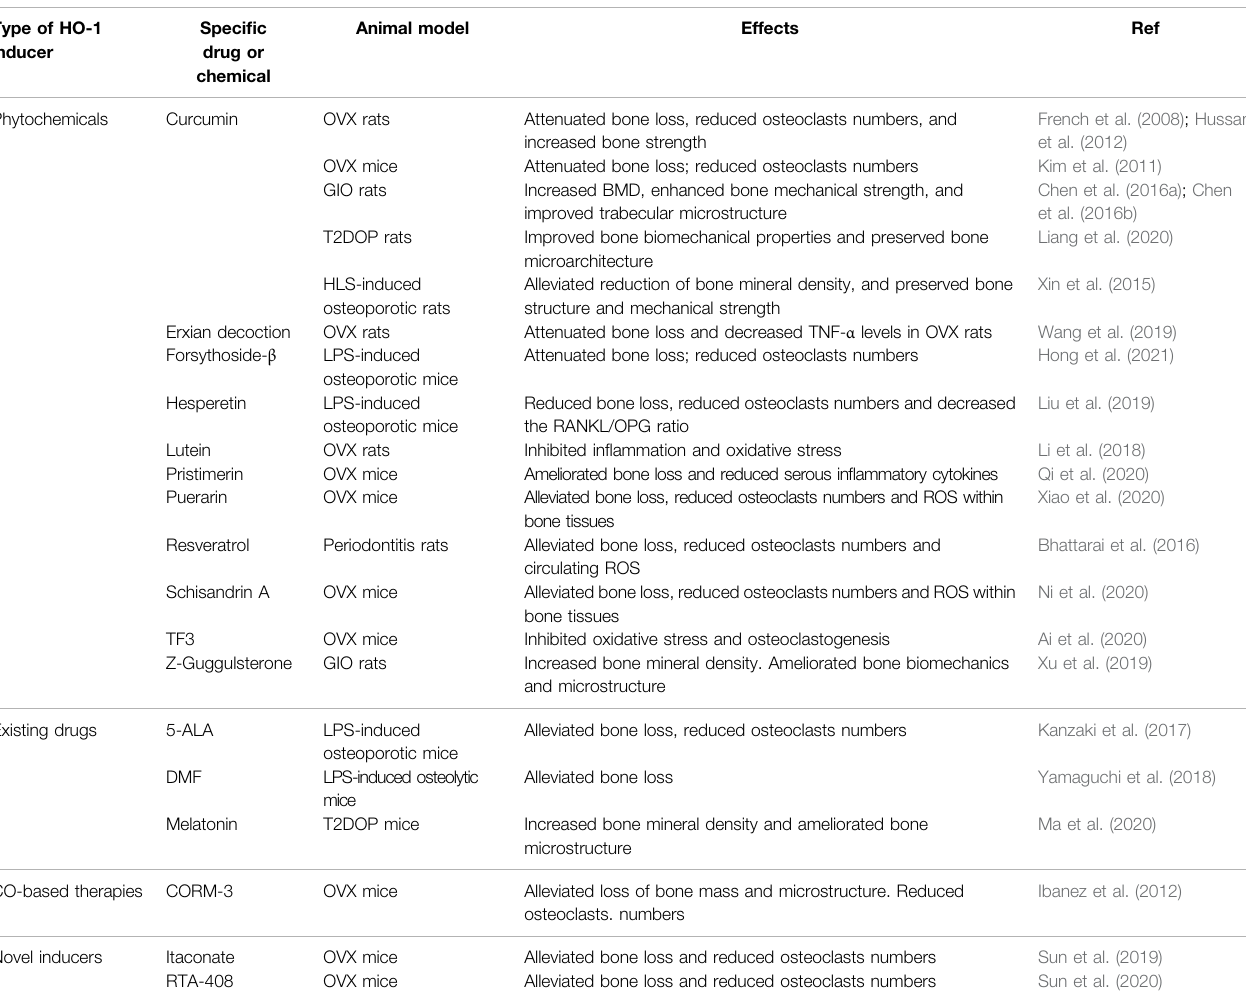
TABLE 2 | Pharmacological treatment towards HO-1 induction for osteoporosis in vivo